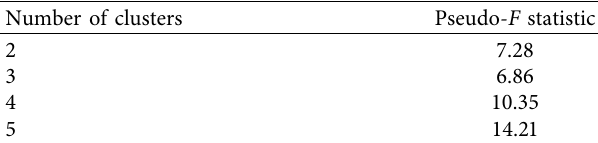
Table 2: Pseudo- F statistics for two to five